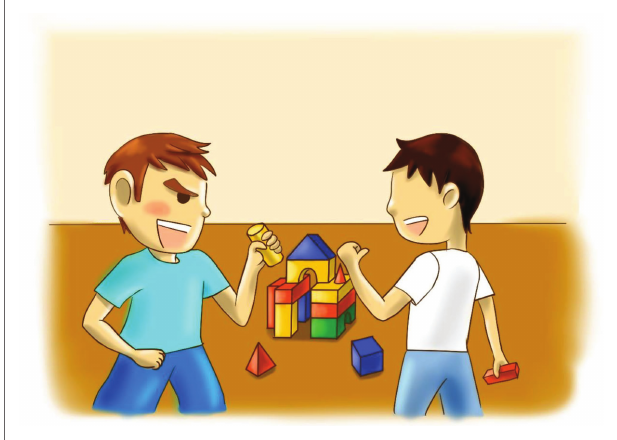
FIGURE 1 | Pictorial achievement goal item for boys to measure other- approach